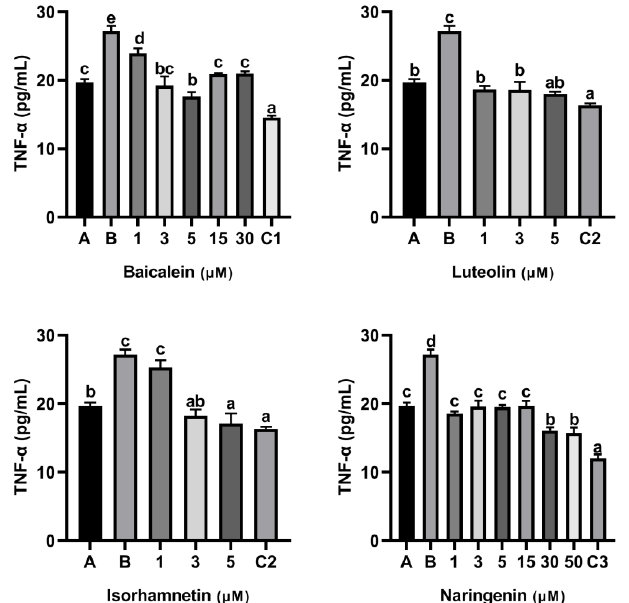
Figure 6. Effect of four flavonoids on the release of TNF- α from KU812 cells induced by ω -5 gliadin-derived peptide P4. A (blank group): only KU812 cells; B (control group): 150 µ g/mL ω -5 gliadin-derived peptide P4+KU812 cells; C1 (positive control group): 30 µ M ketotifen fumarate + KU812 cells; C2 (positive control group): 5 μM ketotifen fumarate + KU812 cells; C3 (positive control group): 50 μM ketotifen fumarate + KU812 cells. Note: different letters indicate significant differ- ences between groups ( p < 0.05).